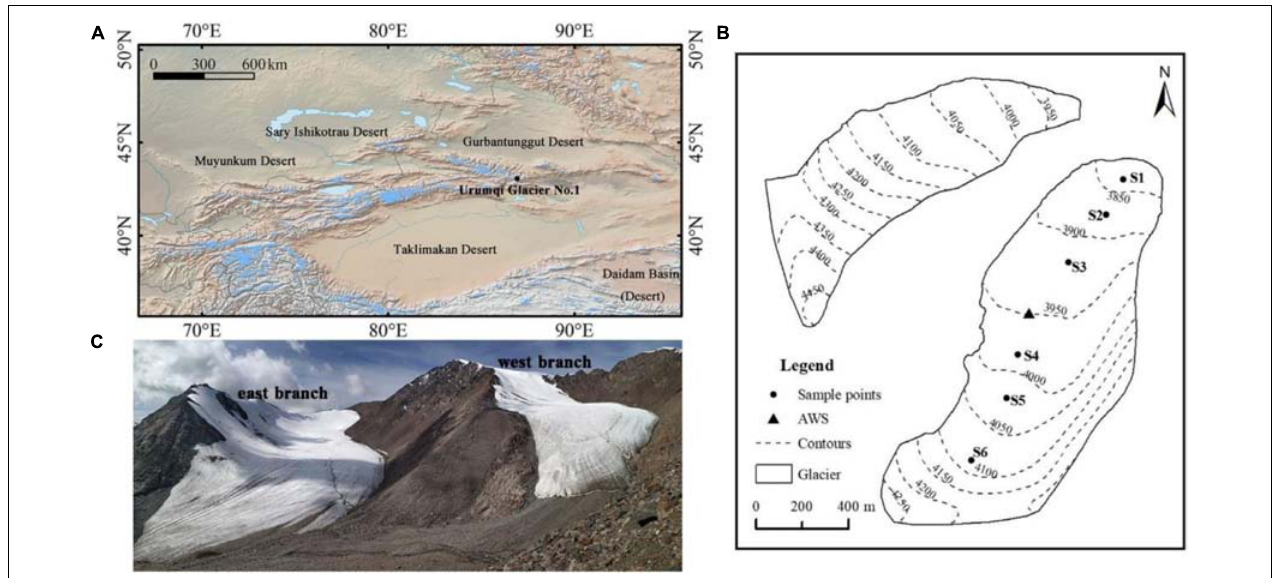
FIGURE 1 | Geographical location (A) and map (B) of Urumqi Glacier No. 1 in Tien Shan, China. Landscape photograph (C) of Urumqi Glacier No. 1 was taken on 20 July 2012.